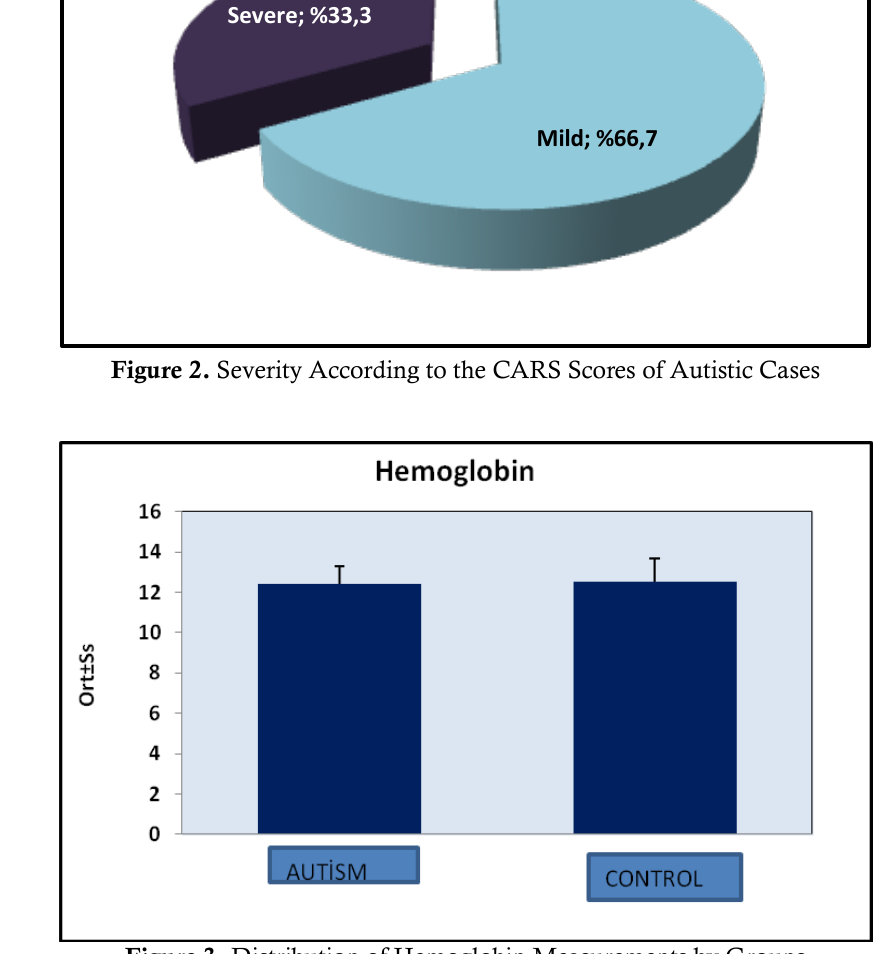
Figure 3. Distribution of Hemoglobin Measurements by